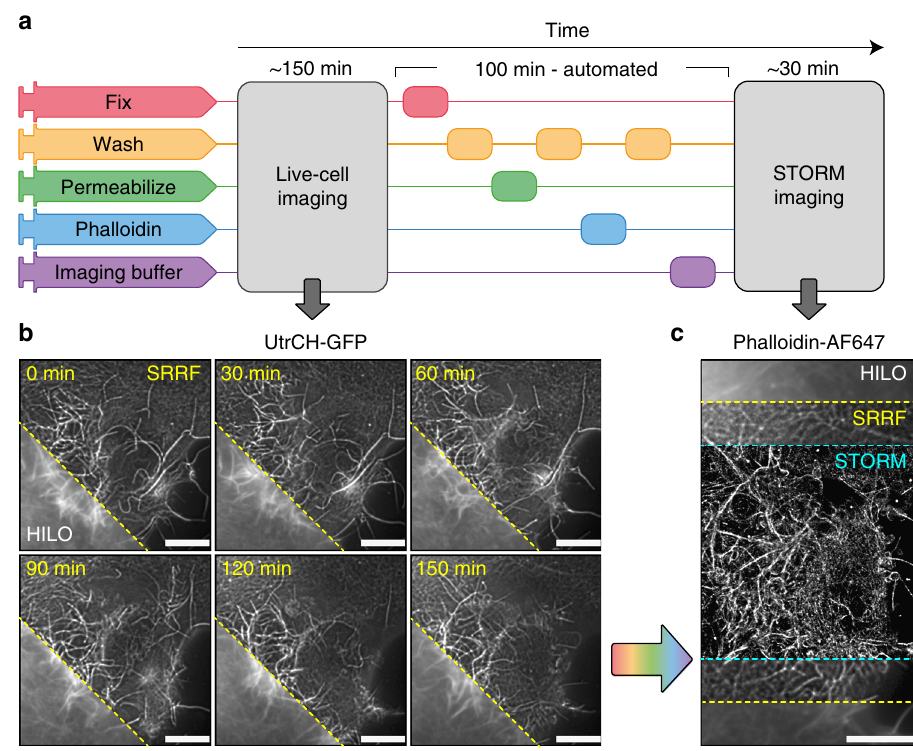
Fig. 4 Super-resolution live-to- fi xed cell imaging of actin. a NanoJ-Fluidics work fl ow used for live-to- fi xed super-resolution imaging. b HILO and SRRF microscopy images of a COS7 cell expressing UtrCH-GFP imaged every 10 min for 150 min (zoomed in region is shown at 30 min intervals, Supplementary Movie 3 shows extended timelapse and fi eld-of-view). c HILO and SRRF microscopy images of UtrCH-GFP at t = 150 min and the corresponding STORM image after fi xation and staining with phalloidin-AF647. Scale bars are 10 μ